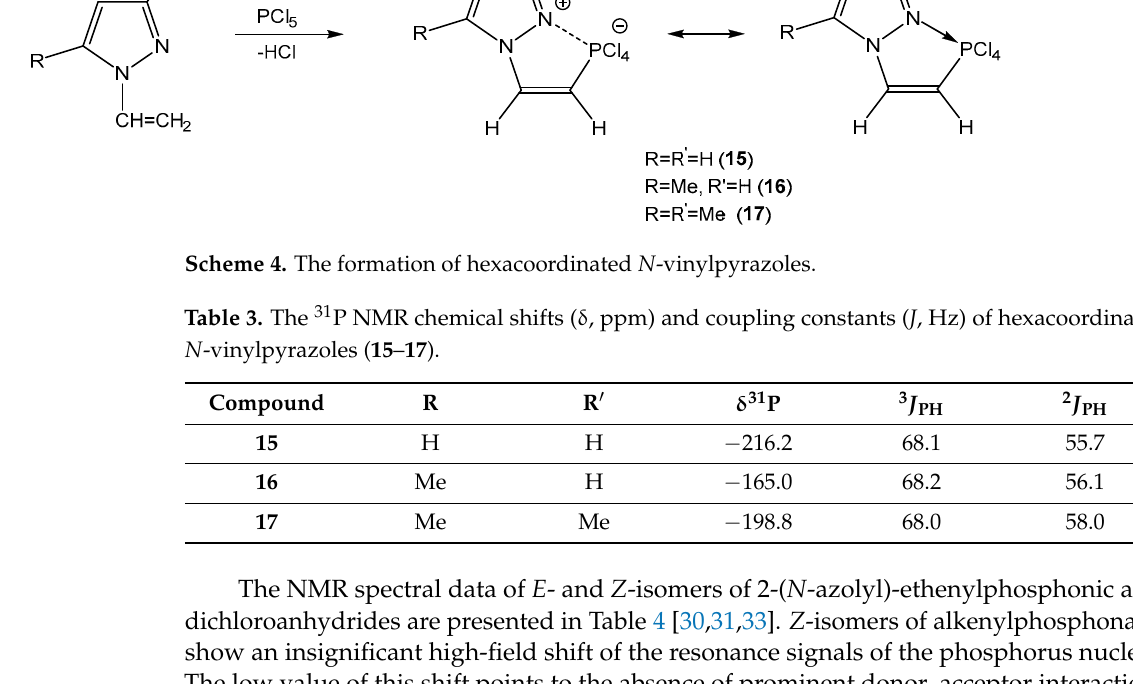
Table 4. The 1 H and 31 P NMR chemical shifts ( δ , ppm) and coupling constants ( J , Hz) of azolylphosphonates 5 – 8 , 10 , 12 , 14 , 19 .